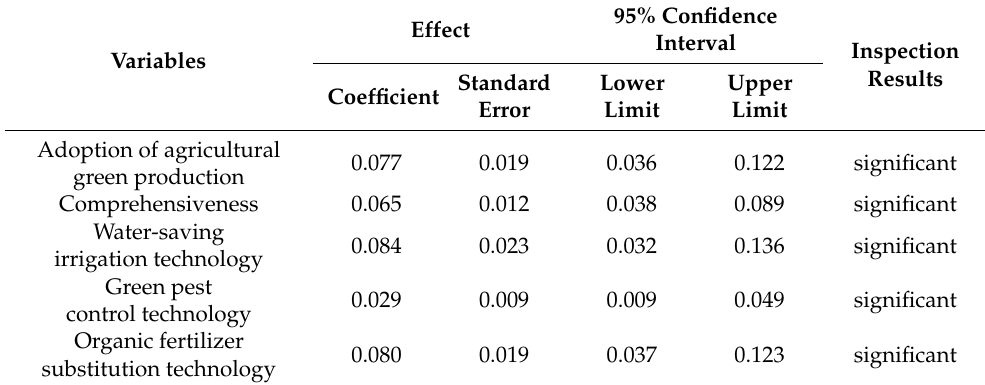
Table 6. Robustness testing results by confidence interval